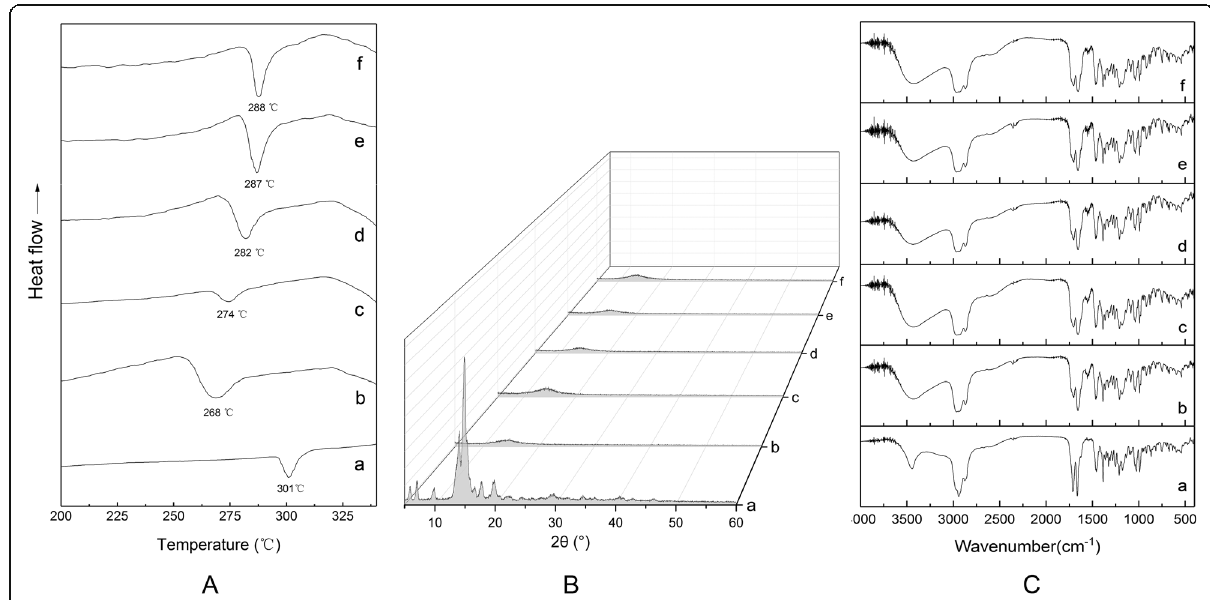
Fig. 6 DSC ( a ), XRD ( b ), and FTIR ( c ) of GA after lyophilization in TBA/water co-solvent with different volume percentage; (a) GA, (b) 40% TBA, ( c )